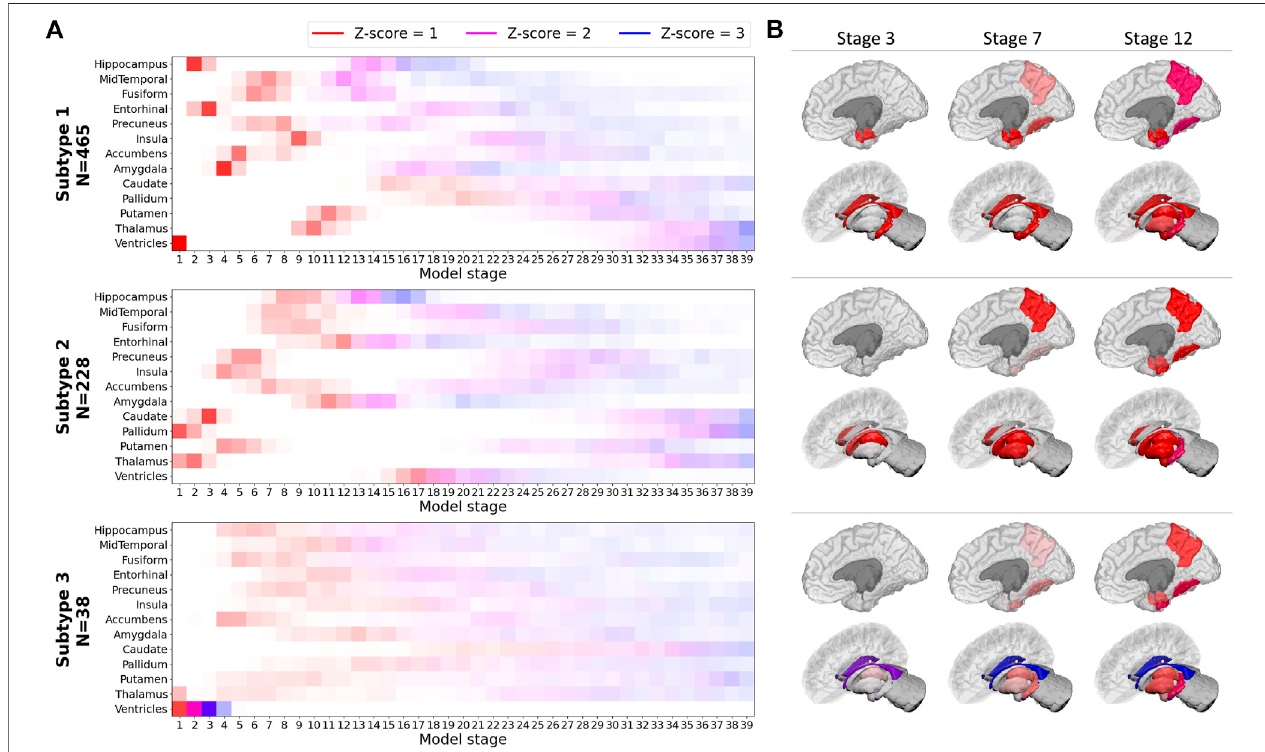
FIGURE 1 | SuStaIn model built on the basis ofvolumetric biomarkers of the training set. (A) Z-score progression patterns for each subtype. Color shades indicate theprobabilityofaZ-scoretoincrement, “ N ” indicatesthenumberofsubjectsfromthetrainingsetassignedtoeachsubtype (B) Representationsofearlystagesforeach